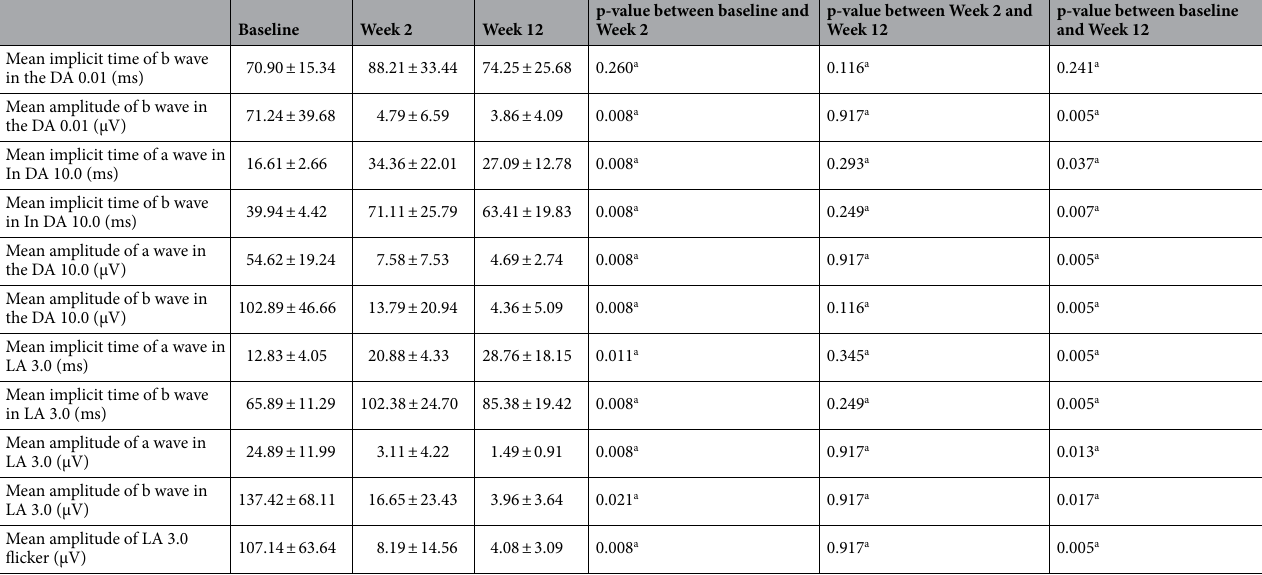
Table 3. The ffERG findings of the 10 mg/mL MNU group (n = 13). DA dark adaptive, LA light adaptive. a Wilcoxon-signed ranked test.